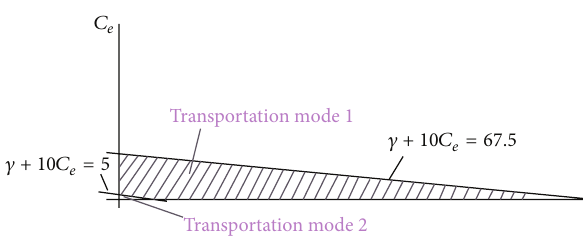
Figure 1: Conditions of transportation mode.